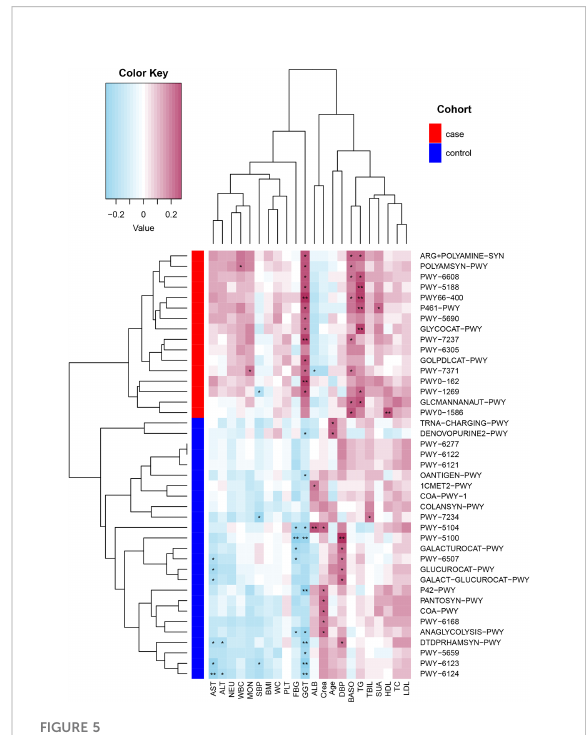
FIGURE 5 Spearman ’ s correlation matrix for the case and control group correlation pathways and clinical index. Blue cell color represented a negative correlation; red cell color represented a positive correlation. * P < 0.05 and ** P <